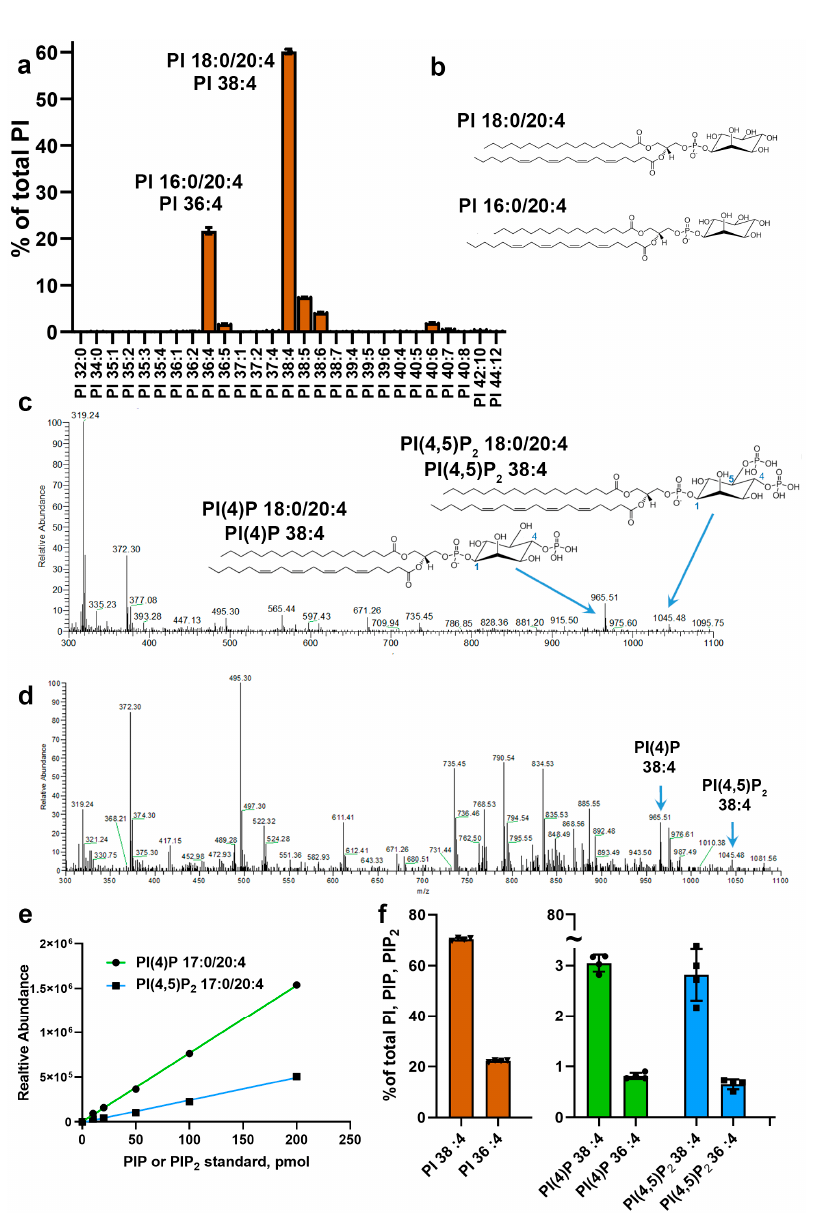
Figure 2. Lipidomic analysis of retinal phosphoinositides. ( a ) Lipid profiles of retinal phosphatidylinositols in 5-week-old wild type mice (mean+/-SD, n = 3). Phosphatidylinositols are shown as a percentage of the total. ( b ) Structures of major arachidonic acid-containing PI species, 16:0/20:4 and 18:0/20:4. ( c ) Mass spectra and structures of PI(4)P 16:0/20:4 and PI(4,5)P 2 18:0/20:4 standards detected by direct infusion with high-resolution mass spectrometry as single ions in negative mode (blue arrows). ( d ) Representative mass spectra of lipids from mouse retinal extracts collected in negative ion mode. Peaks representing endogenous PI(4)P 38:4 and PI(4,5)P 2 38:4 are marked with blue arrows. ( e ) Calibration curves of PI(4)P 17:0/20:4 and PI(4,5)P 2 17:0/20:4 standards are linear in the 10 to 200 pmol range (n = 3; error bars are not plotted due to SD values being smaller than symbol sizes). ( f ) Lipid profiles of 36:4 and 38:4 phosphatidylinositols (PI, brown) and their phosphorylated forms (PI(4)P, green; PI(4,5)P 2 , blue) in dark-adapted mouse retinas (mean+/-SD, n = 4).